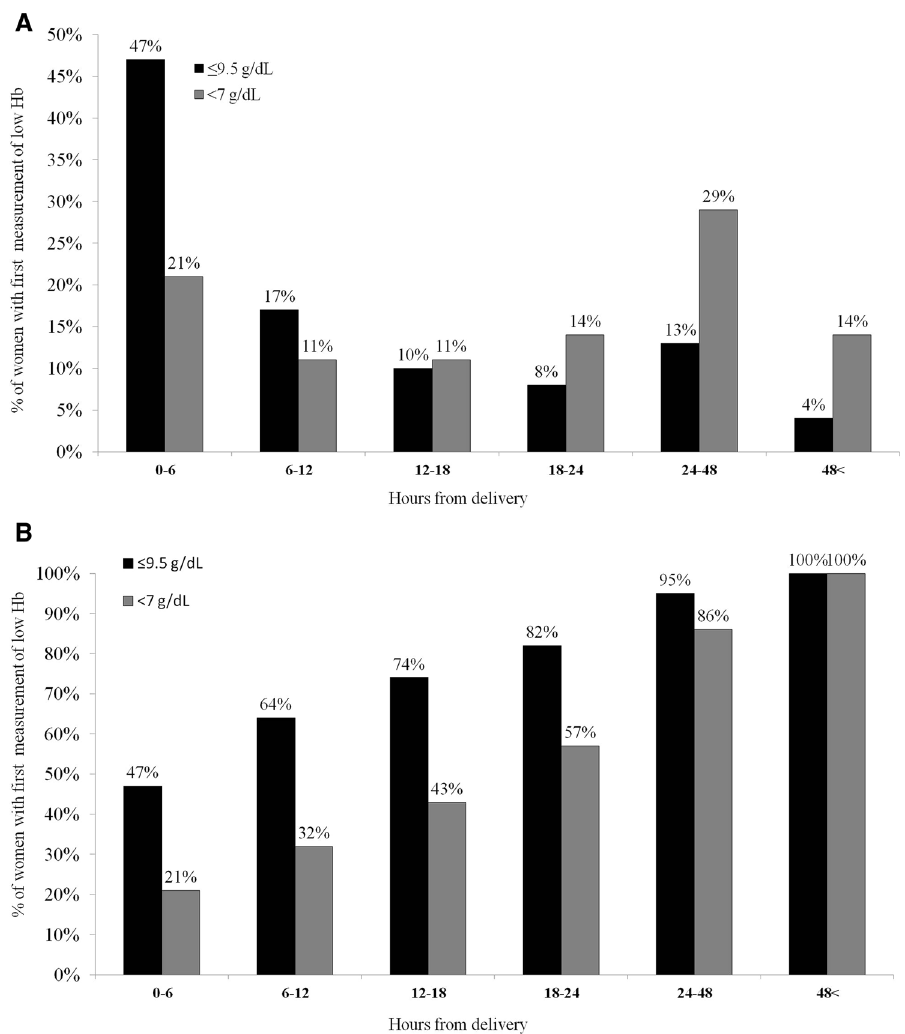
Figure 3. Time to Hb ≤ 9.5 g/dl or Hb < 7 g/dl. Percent (A) and cumulative percent (B) of women with first occurrence of hemoglobin (Hb) value either Hb ≤ 9.5 g/dl (N = 210) or Hb < 7 g/dl (N = 28), at and after